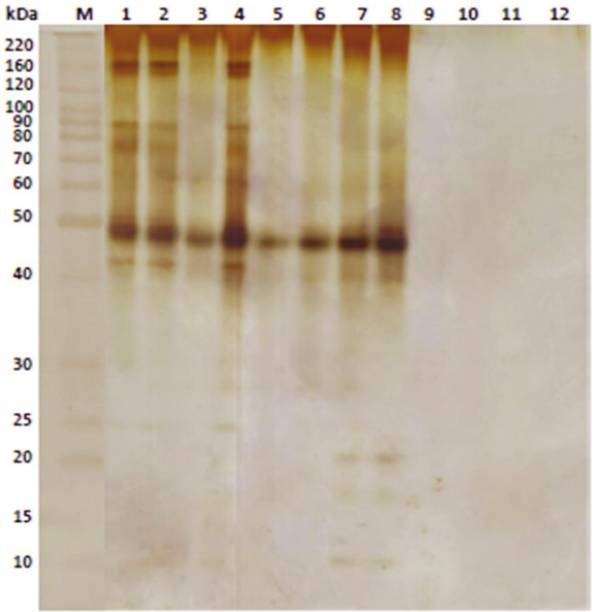
Fig. 3 ­ Protein extraction from shoots of Cereus with erect (samples 1­2, 5­6, 9­10), tortuosus (samples 3, 7, 11) and monstruosus (samples 4, 8, 12) morphologies, with TCA/acetone method (samples 1­4), with phenol extrac­ tion method (samples 5­8) and with the improved­phe­ nol extraction method by He and Wang (2008) (samples 9­12), in the SDS­PAGE system 12%.